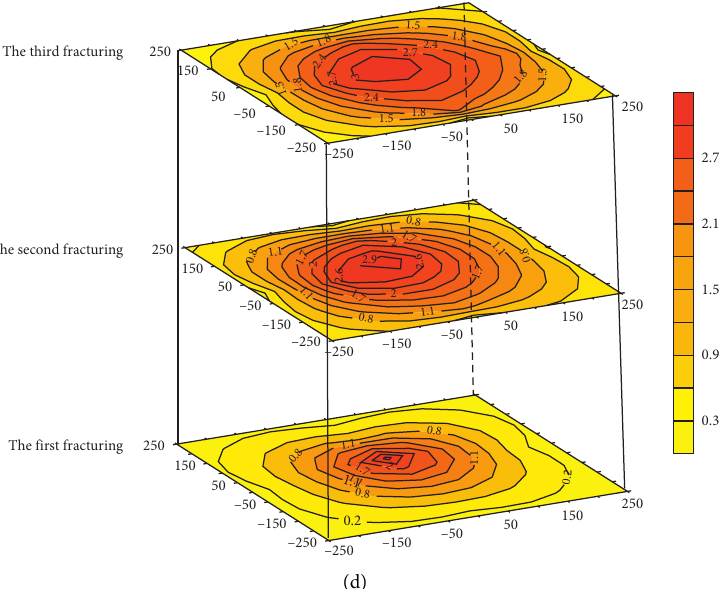
Figure 8: Comparisons of roof stress distributions of coal seam during each hydraulic fracturing: (a) t � 200s; (b) t � 800s; (c) t � 1000s; (d) t � 2000s (the abscissa in the figure represents the offset in the X direction from the fracturing hole, and the ordinate represents the offset in the Y direction from the fracturing hole, and the field value refers to stress